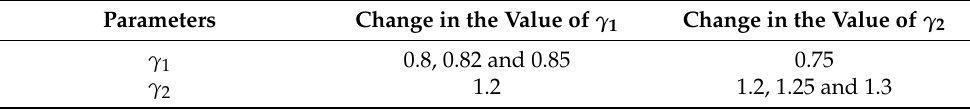
Table 1. Configurative parameters of the